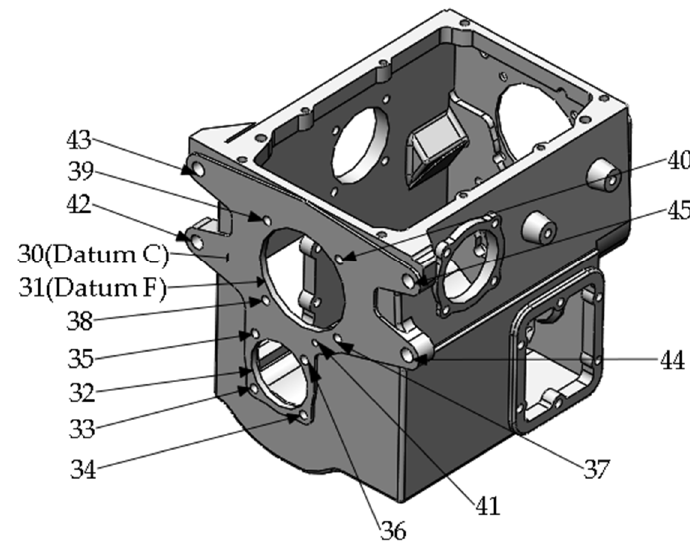
Figure A3. Machining tasks on Rear surface.